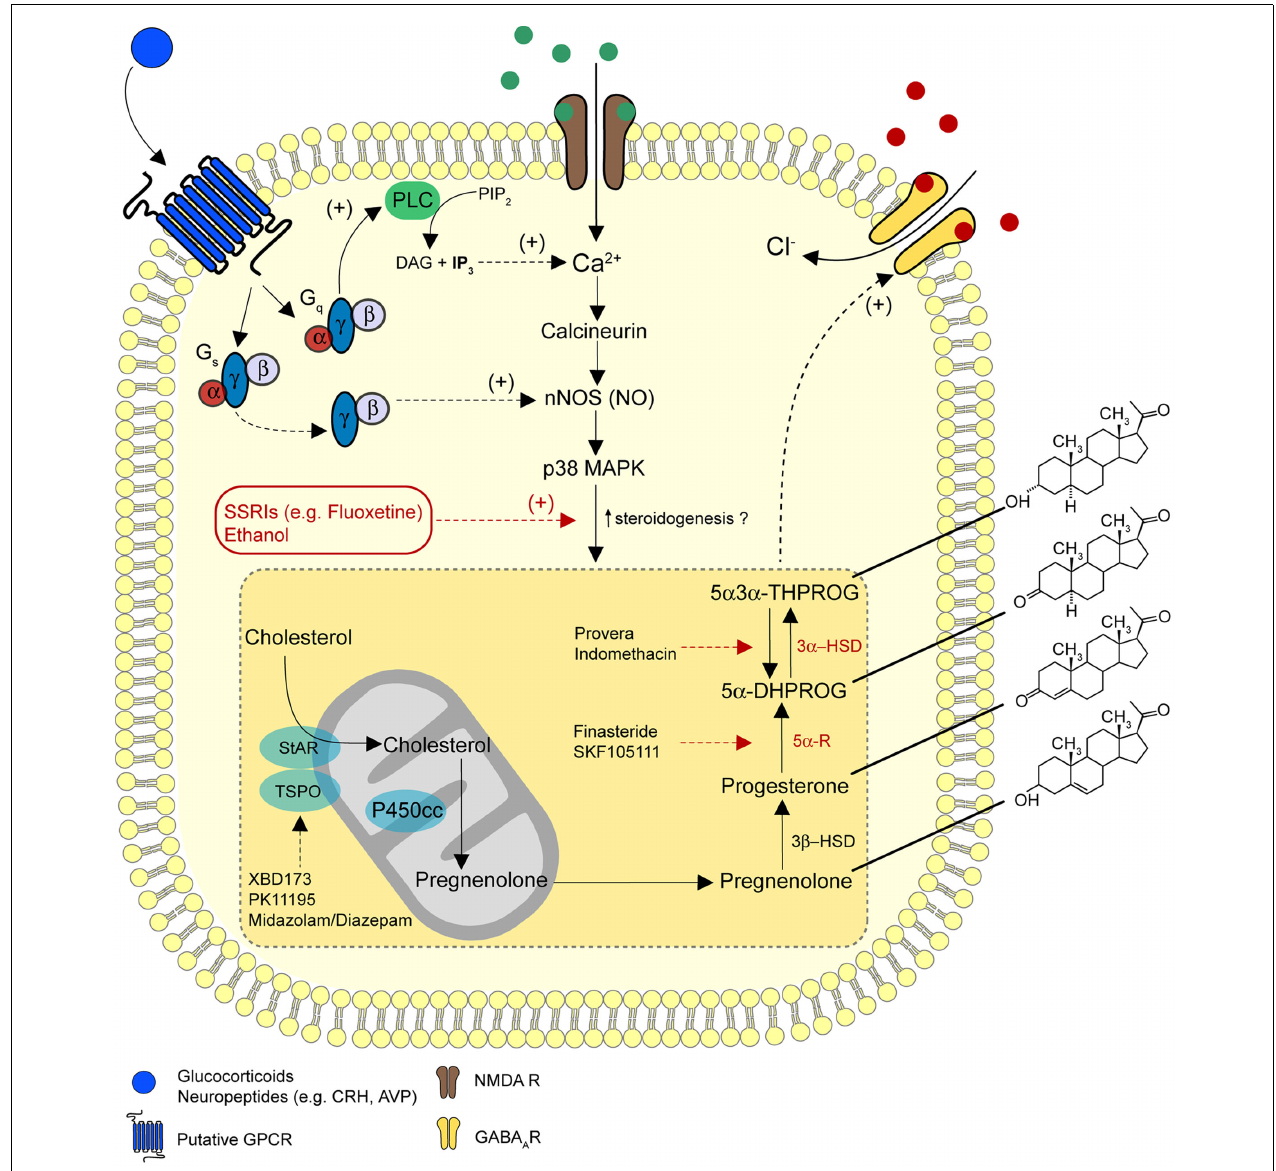
non-genomic effects through the activation of G s - γβ , an effect that stimulates nNOS (Di et al., 2009). Furthermore, a number of stress-related neuropeptides (e.g., CRH, AVP), which are known to signal through G s -coupled receptor complexes may modulate nNOS activity and thus influence neurosteroid synthesis. Receptors for these neuropeptides can additionally couple to G q -proteins to raise intracellular Ca 2 + levels and thus, couple to signaling cascades similar to those associated with NMDA receptor activation.These GPCR-dependent signaling pathways may provide a functional regulatory link between the stress axis and the de novo synthesis of 5 α 3 α